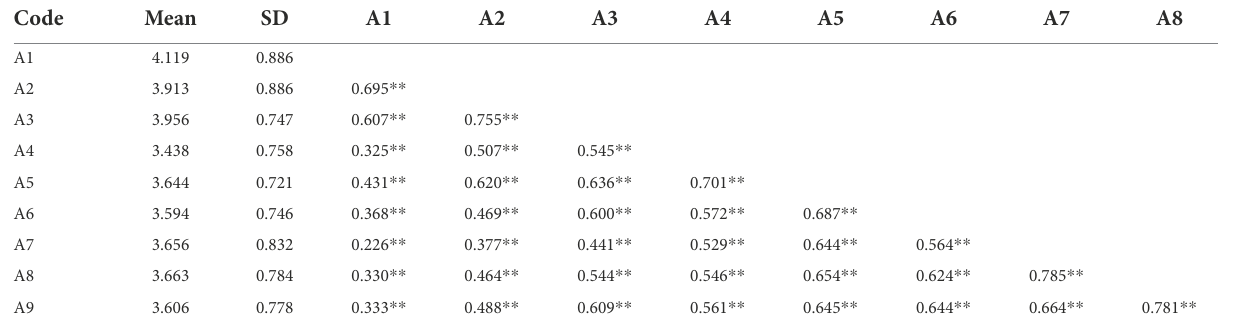
TABLE 2 Pearson correlation of PETJSS items. Code